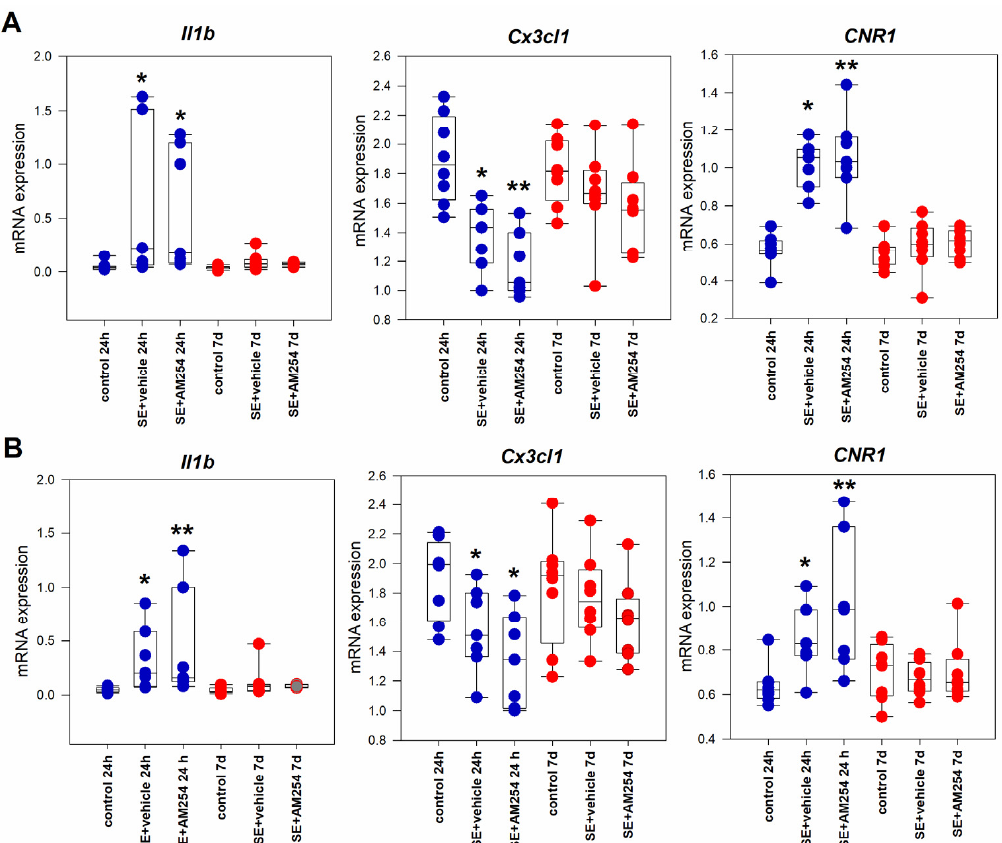
Figure 3. Il1b , Cx3cl1 , and CNR1 mRNA expression in the somatosensory ( A ) and frontal ( B ) cortexes 24 h and 7 days after SE in rats with no SE (control), vehicle-treated treated rats (SE + vehicle), and AM251-treated rats (SE + AM251). Data are presented as medians with interquartile ranges; dots represent individual values for each rat. * statistically significant differences at p < 0.05; ** statistically significant differences at p < 0.005, in comparison with the corresponding control group, Kruskal–Wallis test.